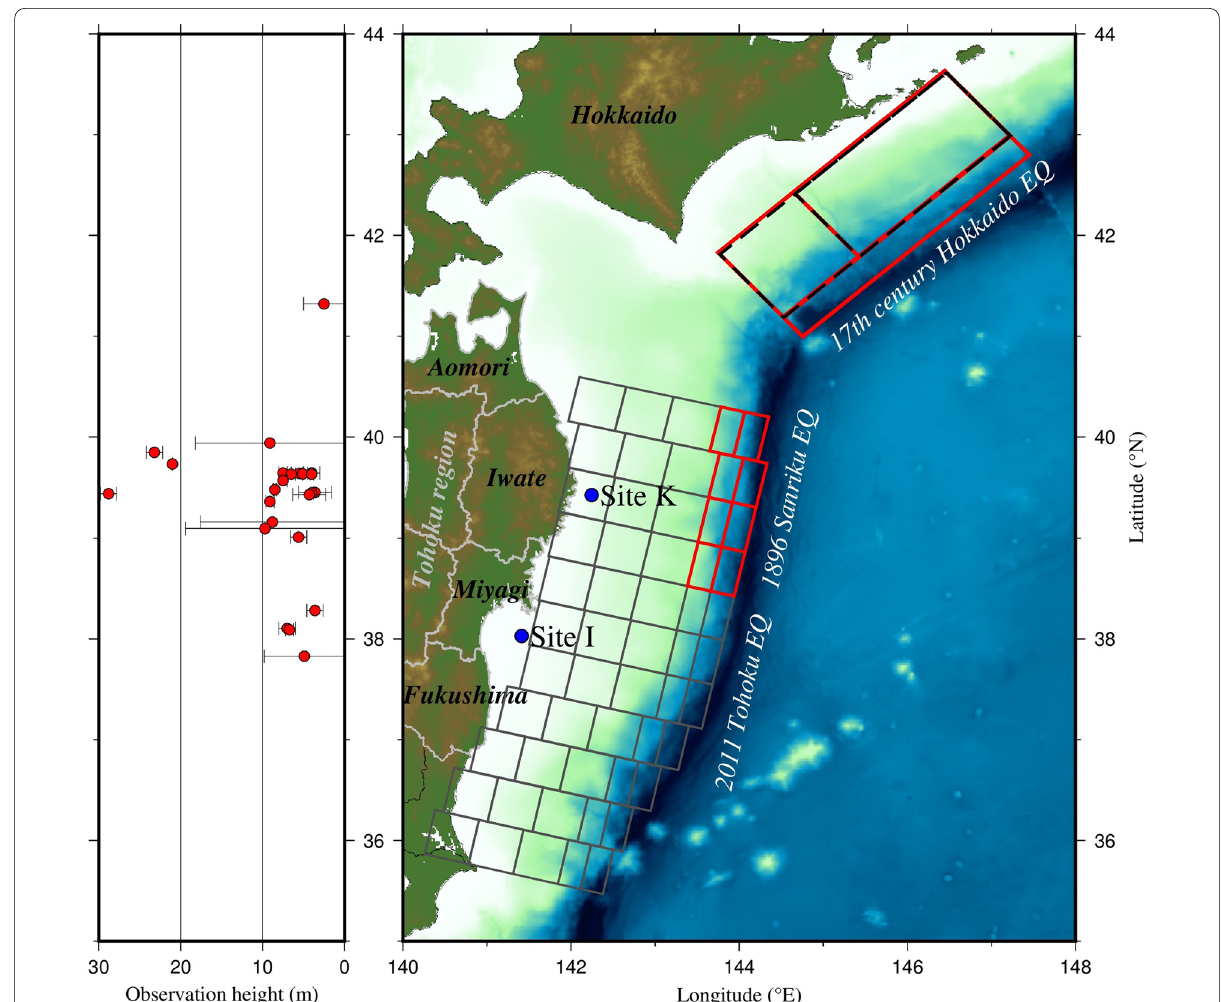
Fig. 1 Observed heights of the 1611 tsunami. The heights along the latitudinal direction reported by Ebina and Imai (2014) (including results from Hatori (1975), Tsuji et al. (2012, 2011), and Tsuji and Ueda (1995)) are displayed in the left panel, and representative source geometries in historical earthquakes indicated by squares are displayed in the right panel. The seventeenth-century earthquake source models were based on Ioki and Tanioka (2016) (red) and Okamura and Namegaya (2011) (black); the 1896 earthquake source model was based on Satake et al. (2017) (red); the 2011 earthquake source model was based on Satake et al. (2013)